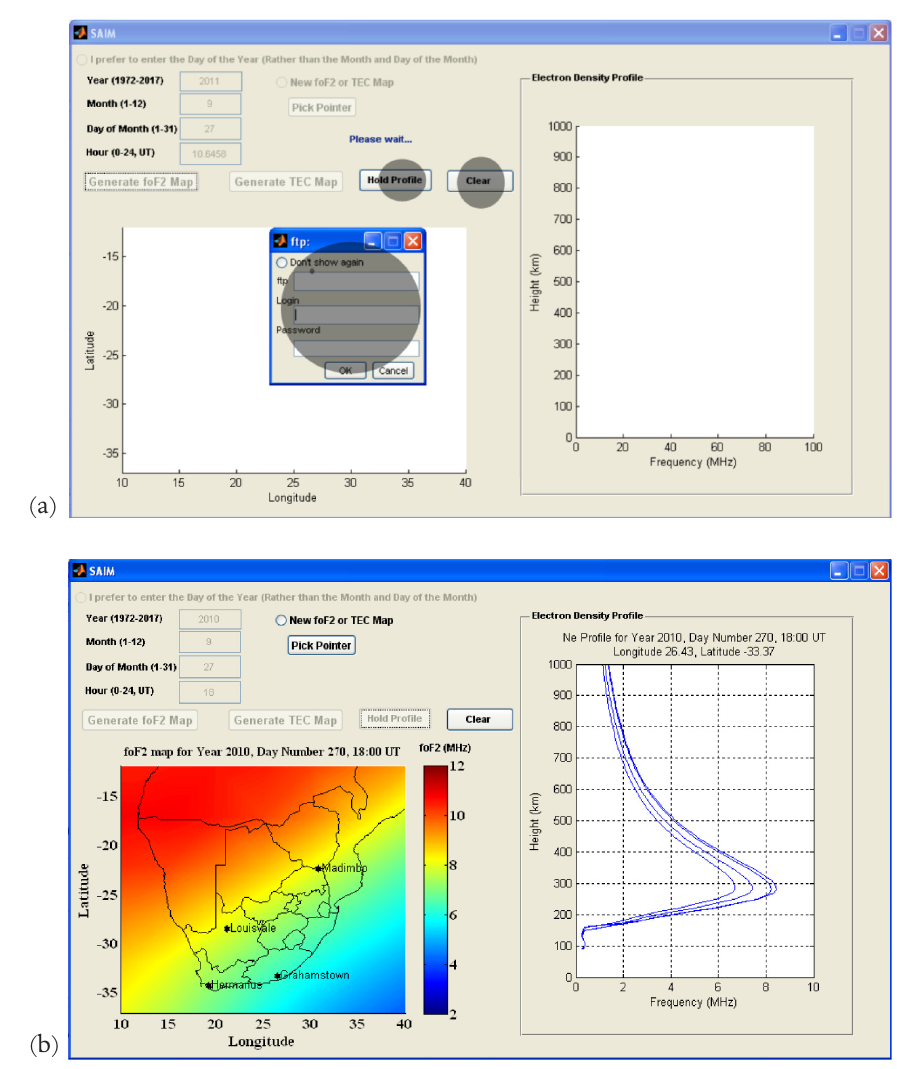
Figure 11. (a) The new SAIM interface. (b) An example of a comparison of profiles from different locations on the map. Time: 17:00 UT,